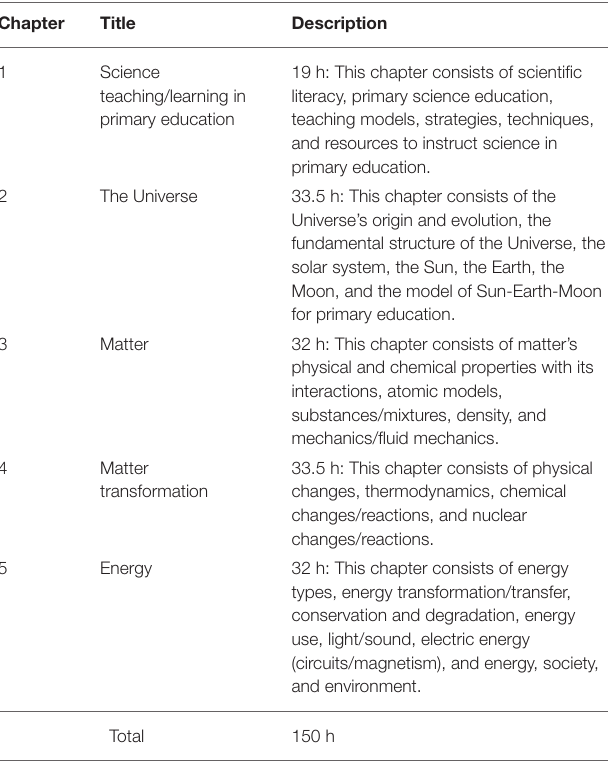
TABLE 2 | The general information of the subject implemented into the course for F2F and F2S flipped